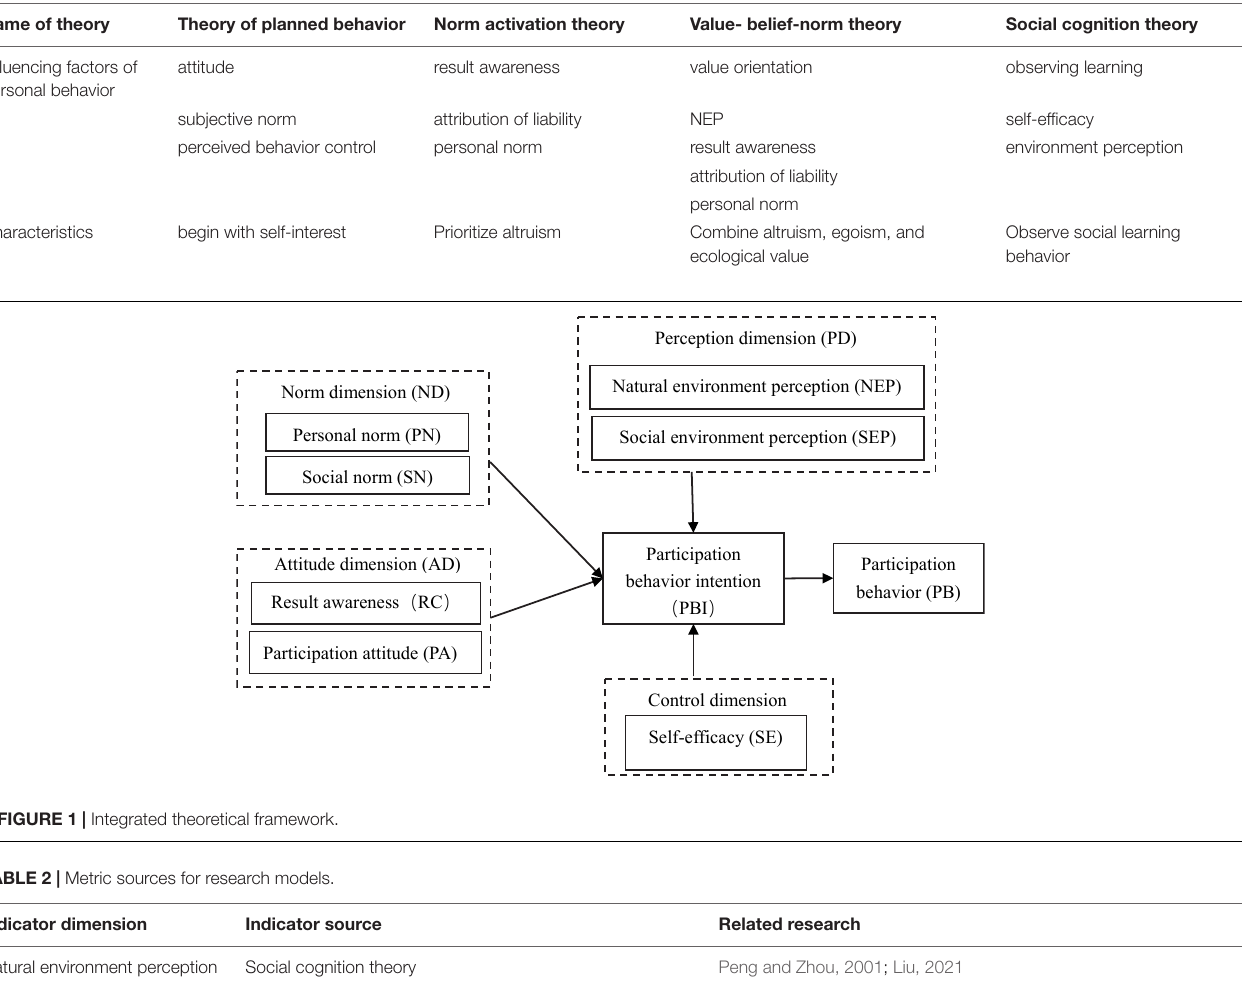
TABLE 1 | Comparison of the main theories of personal behavior research.